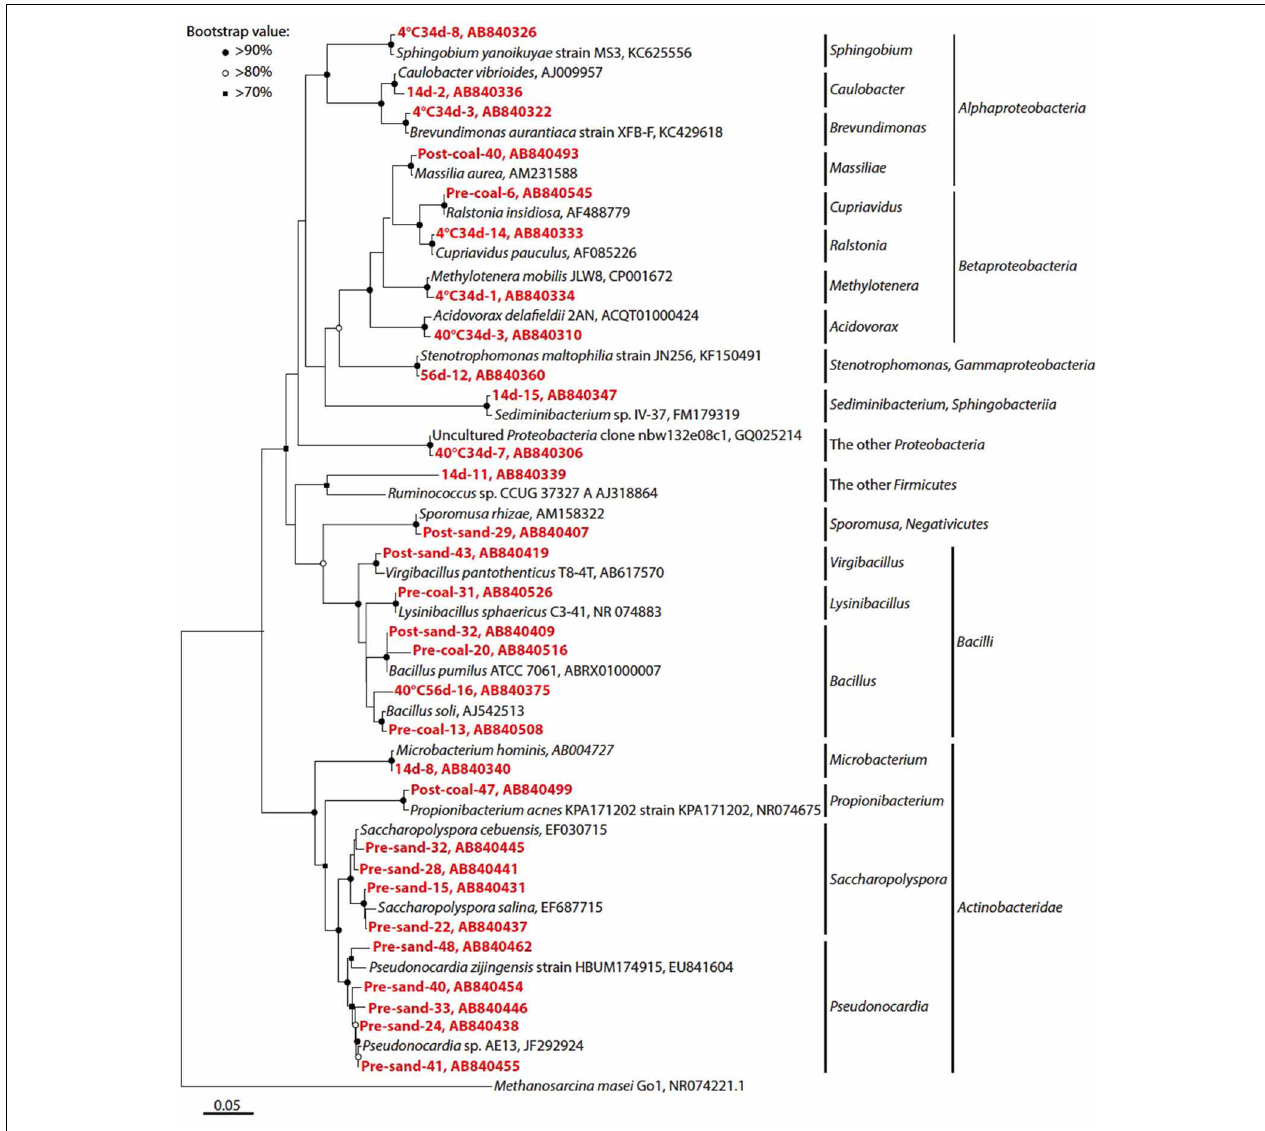
FIGURE 6 | Phylogenetic analysis of bacterial 16S rRNA gene sequences. Only representative sequences from each operational taxonomic unit (OTU) at a 97% cut-off were presented. Accession numbers are also shown after each strain or clone name. Red colored